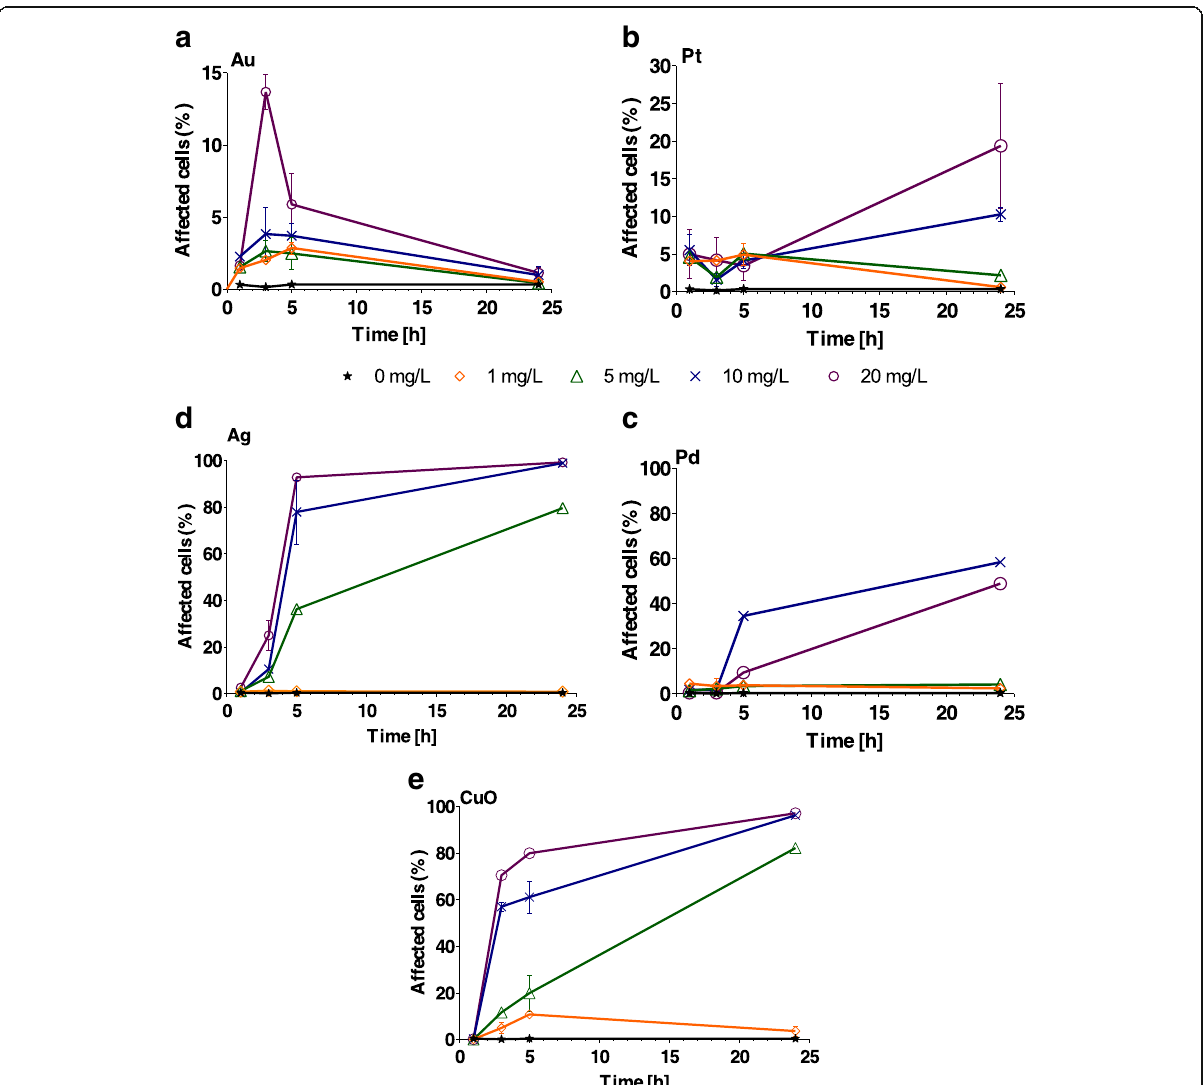
Fig. 3 Percentage of Chlamydomonas reinhardtii cells exhibiting oxidative stress following exposure to increasing concentrations (1, 5, 10, and 20 mg/L) of a Au, b Pt, c Pd, d Ag and e CuO nanoparticles after 1, 3, 5 and 24 h. The error bars represent the standard deviation of repeated experiments using duplicate samples. Note different y -axis scales for Au and